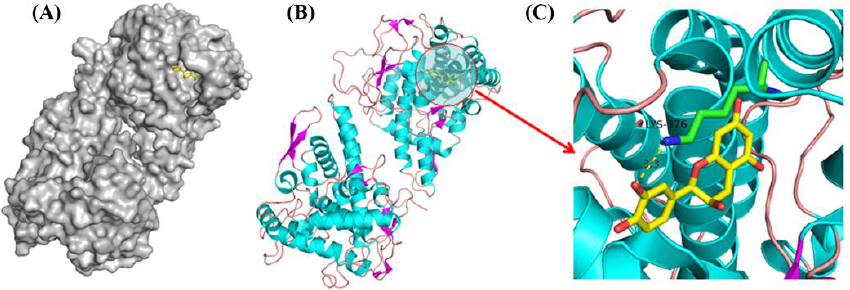
Figure 9. ( A ) Surface and ( B ) cartoon diagrams of the predicted binding mode of epicatechin, the main constitutive unit of ASBPs to tyrosinase; ( C ) Close-up of the interaction between epicatechin and tyrosinase.